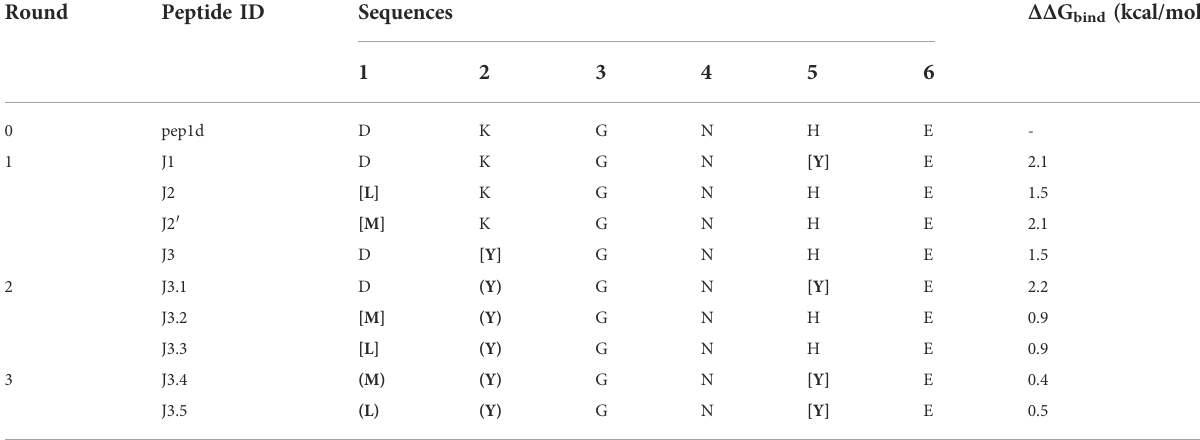
TABLE 1 Selected new peptides from each round of optimization to experimental veri fi cation. The most favored changes in Δ G bind were shown for residue replacement indicated by square brackets. The residues in round brackets indicated the advantageous mutation(s) adopted from the previous run.